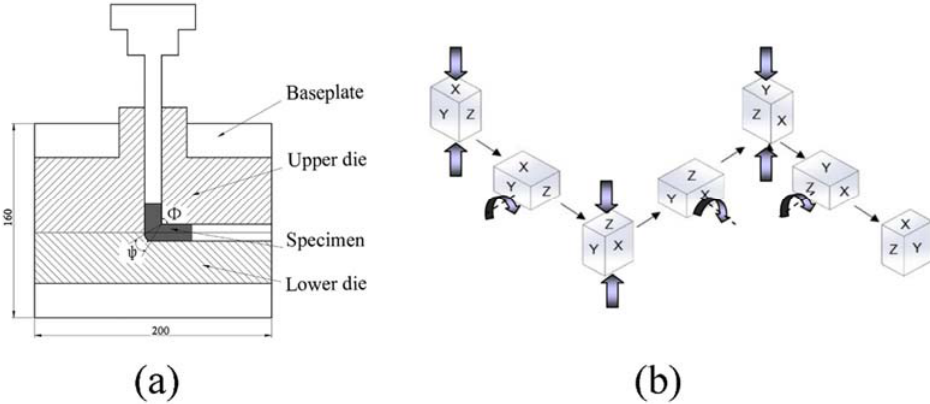
Figure 1. The diagram of 6061 aluminum alloy processed by CECC. ( a ) ECAP (Equal channel angular pressing); ( b ) MAC (Muti ‐ axial compression) processes.